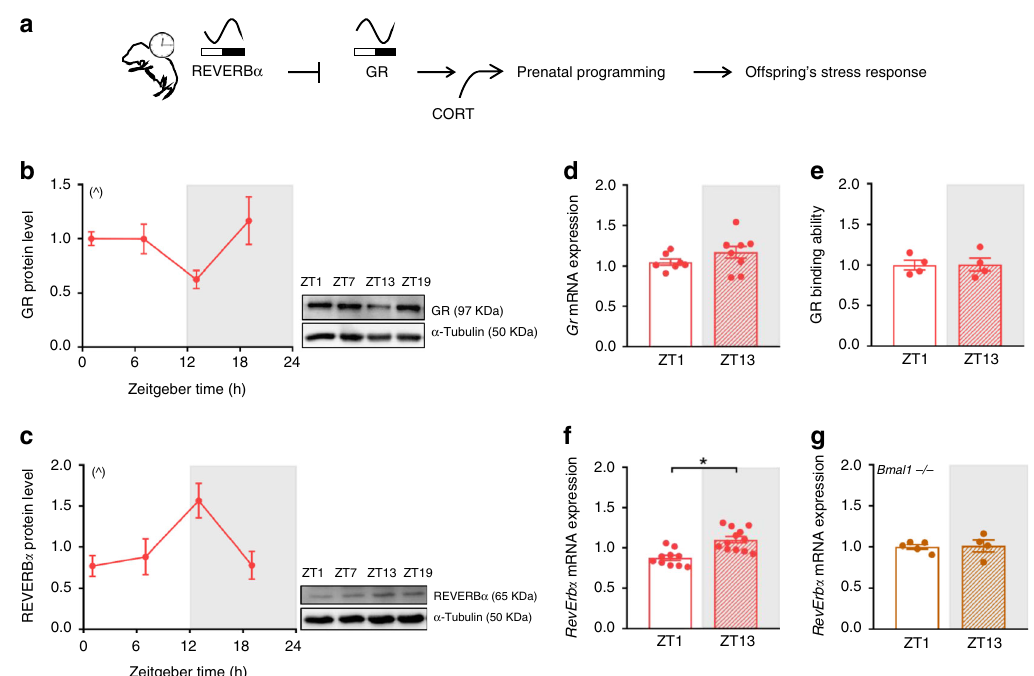
Fig. 4 In the fetal hypothalamus, diurnal rhythms of GR and REVERB α are anti-phasic. a Working model of reverse erythroblastoma alpha (REVERB α )- mediated regulation of rhythmic glucocorticoid receptor (GR) protein amount and prenatal programming of the offspring ’ s stress response. b , c Circadian pro fi le of GR ( b ) and REVERB α ( c ) protein in fetal hypothalami obtained from naive mothers euthanized every 6 h (at Zeitgeber time (ZT) 1, 7, 13 and 19) during gestational day (GD) 15.5 to 16.5, (GR n = 6 ZT1, n = 5 ZT7, n = 5 ZT13, n = 5 ZT19 and REVERB α n = 6 for all time points). Representative Western blot results are shown; samples were run in duplicates and α -Tubulin was used as loading control. d Gr mRNA expression in fetal hypothalami from naive pregnant mothers euthanized at ZT1 ( n = 7) and ZT13 ( n = 8). e GR binding to glucocorticoid receptor binding elements ( GRE s) assessed in fetal hypothalami from naive pregnant mothers ( n = 4 for both time points). f , g RevErb α mRNA expression in wild-type ( n = 10 ZT1 and n = 12 ZT13) ( f ) and brain and muscle aryl hydrocarbon receptor nuclear translocator-like 1 ( Bmal1 − / − ) ( g ) fetal hypothalamus ( n = 5 ZT1 and n = 4 ZT13) from naive mothers. qPCRs for gene expression and GR binding assays were run in duplicates. All data are expressed as means ± SEM. In b , c signi fi cant circadian rhythmicity was determined by CircWave v1.4 which fi ts a standard cosine function to an averaged de-trended data assuming a period of 24 h, a p < 0.05 was considered signi fi cant (^, b r 2 = 0.37, p = 0.05; c r 2 = 0.38, p = 0.028). In f data were analyzed by two-sided unpaired t -test ( f t = 4.35, df = 20, * p = 0.0003). Source data are provided as a Source Data fi